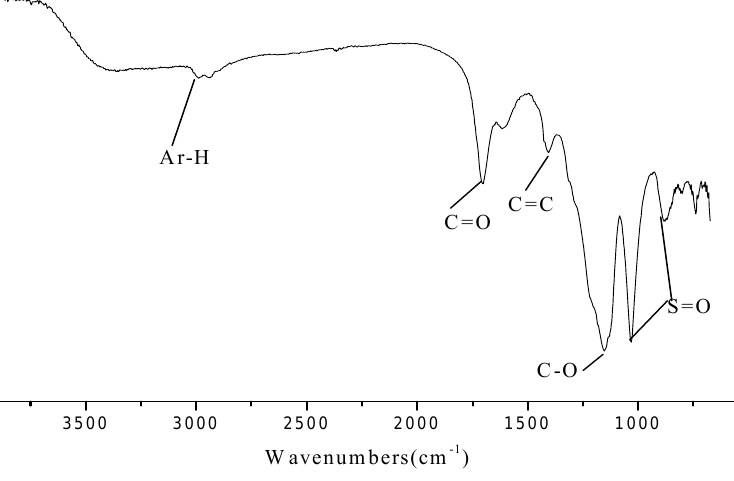
Figure 1. The IR spectrum of the carbon based